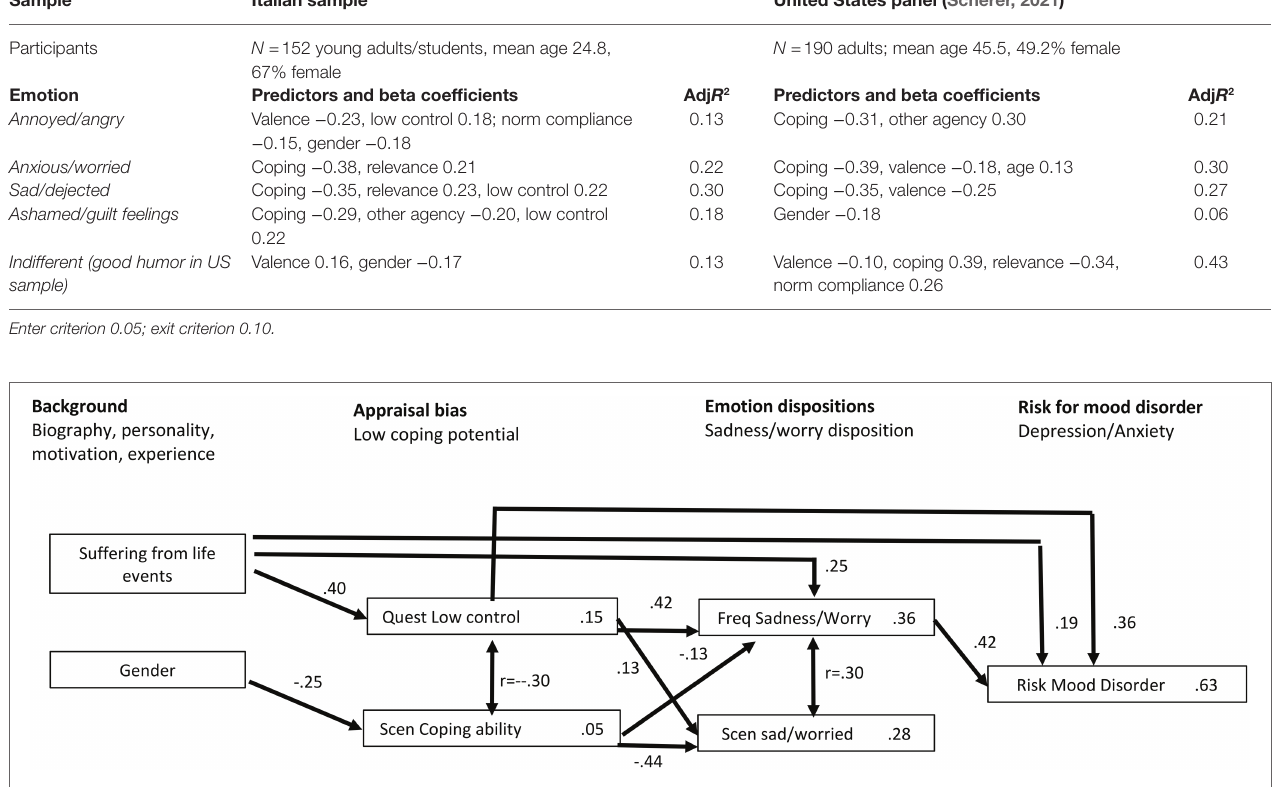
TABLE 4 | Study 2: hierarchical stepwise linear regressions of appraisal ratings, low control/power beliefs, and background variables on emotion ratings. Sample